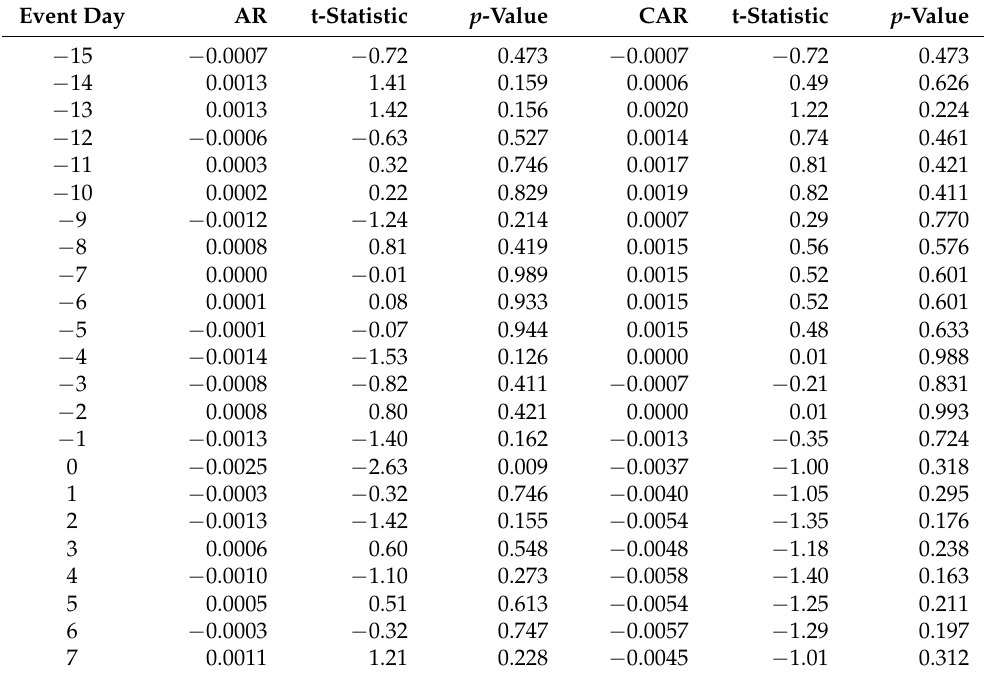
Table A2. Abnormal-return statistics for neutral